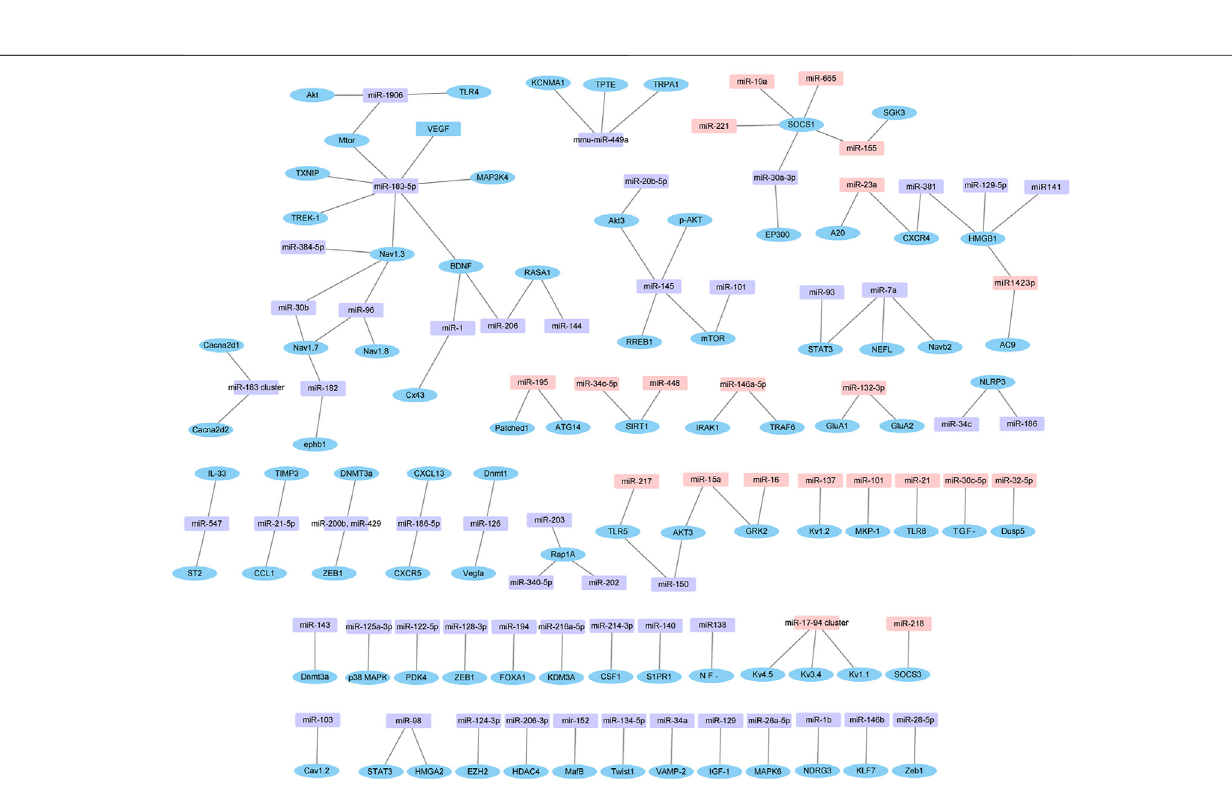
Frontiers in Molecular Biosciences |